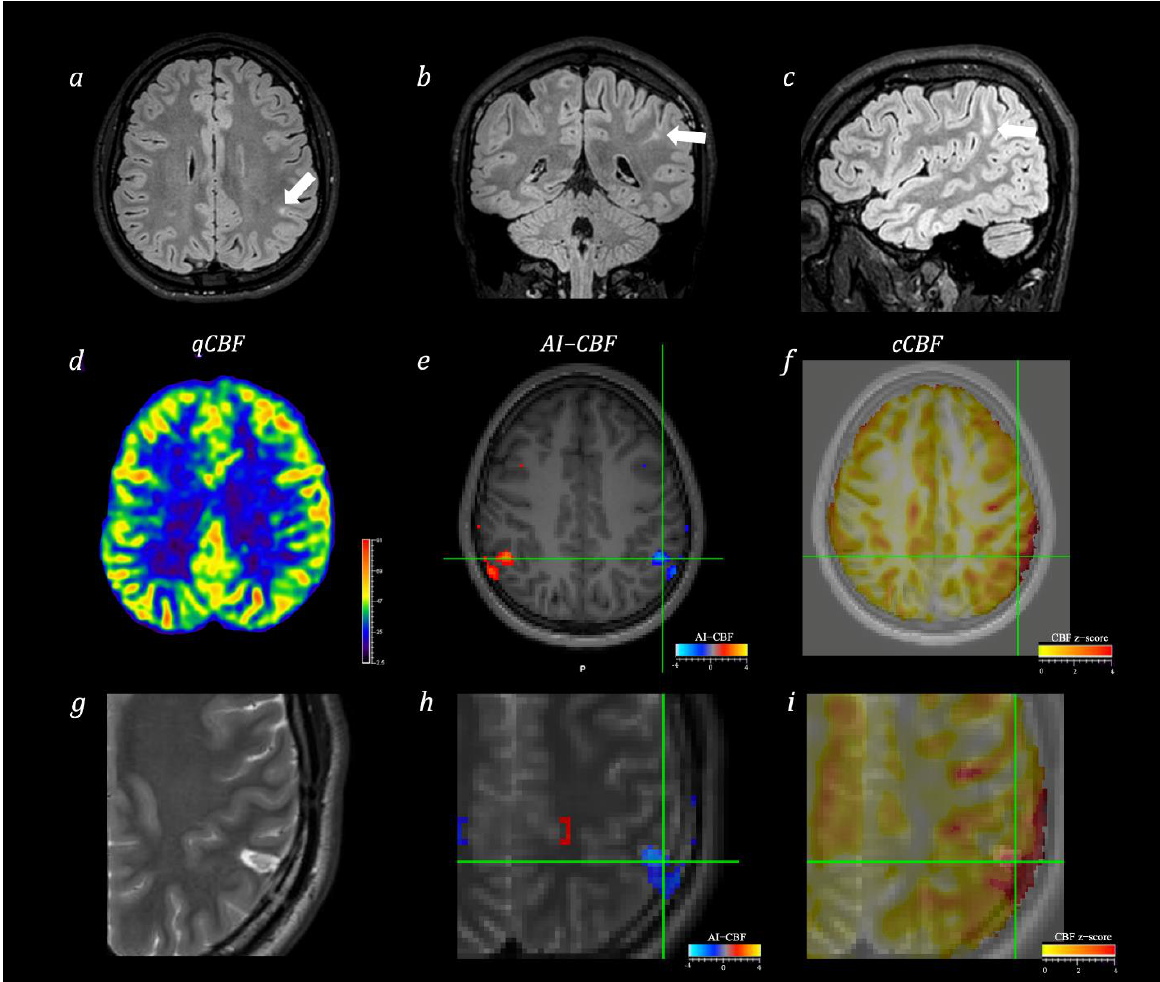
Figure 2. MR images of Engel class I patient with focal left parietal epilepsy undergoing surgery. 3D-FLAIR images ( a – c ) show left parietal bottom-of-sulcus cortical dysplasia (white arrows). Qualitative analysis of the ASL-CBF map ( d ) identified a slight reduction of CBF in the left parietal region. Quantitative voxel-based analysis of the CBF Asymmetry Index ( e ) confirmed a region of asymmetry in the parietal lobes with reduced perfusion in the left side. Quantitative voxel-base analysis of cCBF ( f ) identified in the same region of the left parietal lobe a region of significant reduction of CBF compared with age-matched healthy controls. Axial T2-weighted image acquired after surgery ( g ) shows a resected area in the left parietal lobe. AI-CBF ( h ) and cCBF z-score maps ( i ) overlaid on post-surgery T2-weighted image show perfect correspondence of the cluster of significant results with the area of resected lesion.